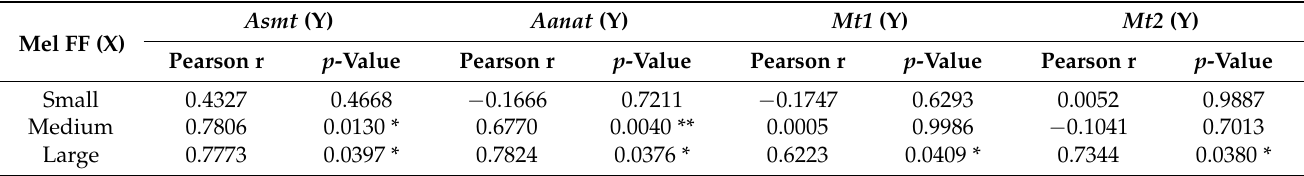
Figure 4. Seasonal melatonin concentrations (pg/mL) in mare follicular fluid from different sizes of ovarian follicles. Small: <20 mm; Medium: 20 to 35 mm; Large: >35 mm. Two-way ANOVA with Bonferroni’s multiple comparisons post-test was used to determine significant differences (plotted as mean ± SEM). Asterisks represent seasonal differences (** p < 0.01, *** p < 0.001). ns: non-significant. Table 3. Correlation between melatonin (Mel) concentration in follicular fluid (FF) and mRNA of melatonin-related genes in developing follicles (small, medium and large).